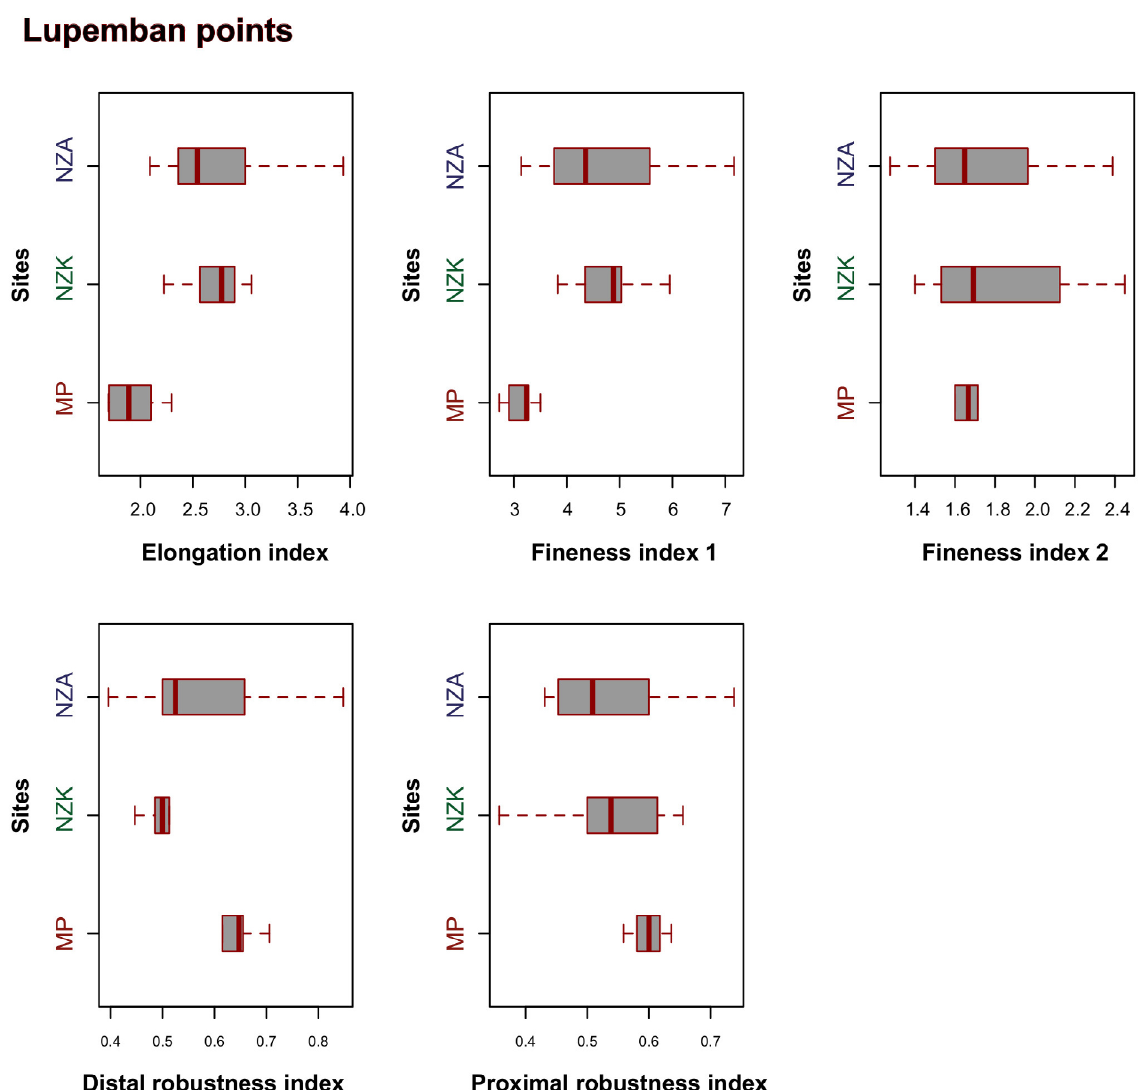
Figure 10. Boxplots for indices and sites, integrating the Lupemban points only. (Elongation indice: NZA X̅ =2.696, sd=0.4636399, NZK X̅ =2.726, sd=0.2755363, MP X̅ =1.936, sd=0.2615799, Fineness index 1: NZA X̅ =4.750, sd=1.268371, NZK X̅ =4.895, sd=0.8399489, MP X̅ =3.126, sd=0.3109412, Fineness index 2: NZA X̅ =1.755, sd=0.3252214, NZK X̅ =1.813, sd=0.3661243, MP X̅ =1.624, sd=0.1215206, Distal robustness index: NZA X̅ =0.5765, sd=0.07690242, NZK X̅ =0.5135, sd=0.0790596, MP X̅ =0.6247, sd=0.07690242, Proximal robustness index: NZA X̅ =0.5501, sd=0.1242465, NZK X̅ =0.5284, sd=0.1050943, MP X̅ =0.5987,